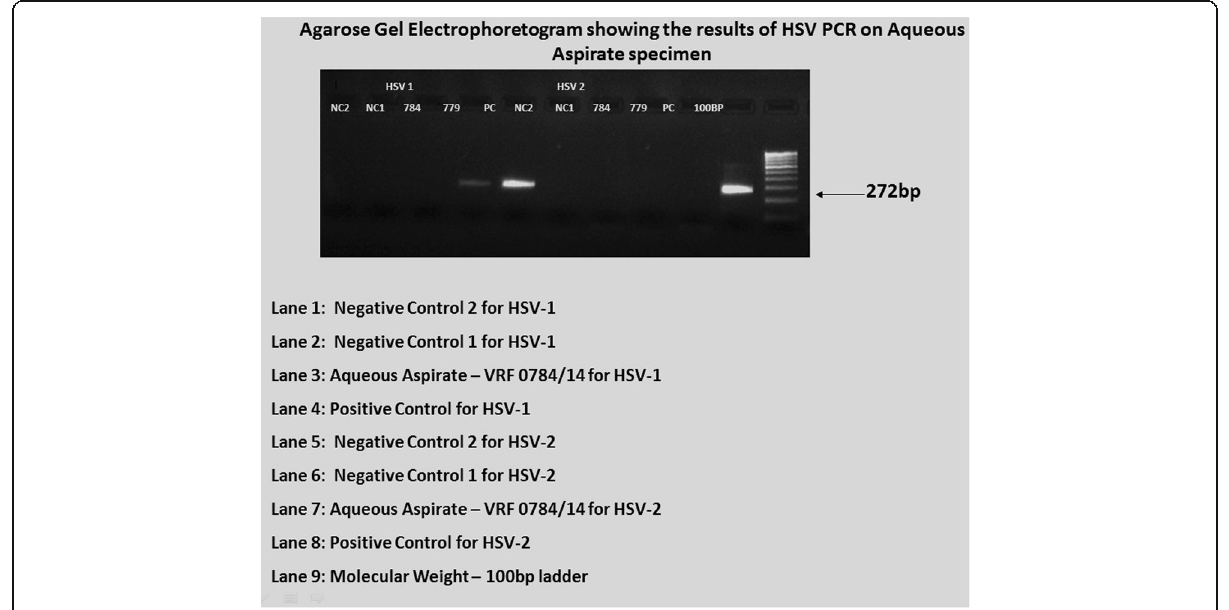
Fig. 2 Agarose gel electophotogram showing the detection of herpes simplex virus (HSV) genome